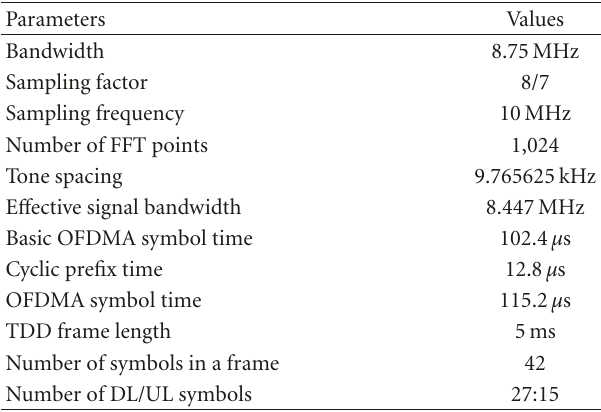
Table 6: Main system parameters for the mobile WiMAX systems